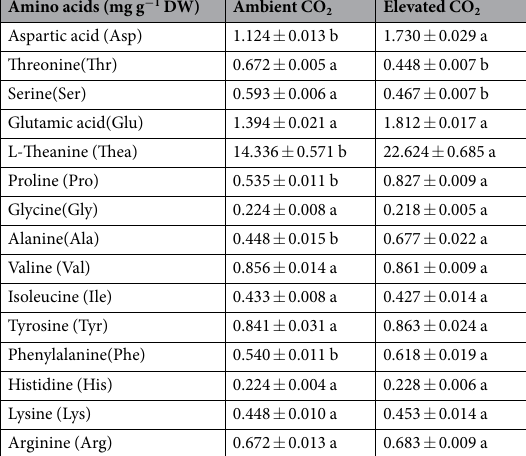
Table 2. Effect of elevated CO 2 concentration (800 µ mol mol − 1 for 24 d) on amino acids concentration in tea leaves. Mean denoted by different letters indicate significant differences between the treatments ( P < 0 . 05 ). DW, Dry